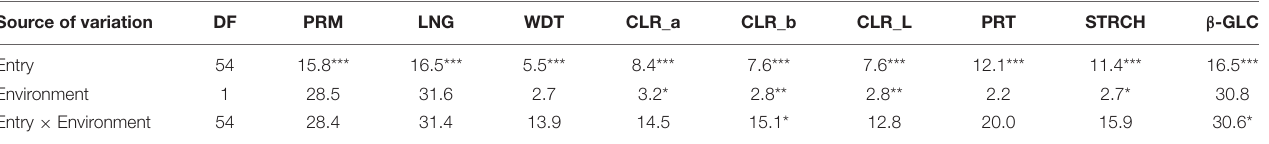
( Figure 5 ). On the opposite side, the lines derived from Djebali independently their selection status, along with their original population were those with the lower values for grain starch content ( Figure 5